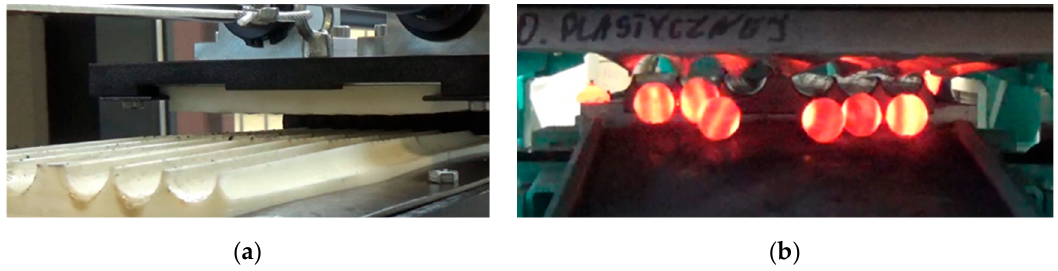
Figure 8. Cross rolling of six balls in ( a ) the model rolling mill; ( b ) a flat wedge rolling mill.